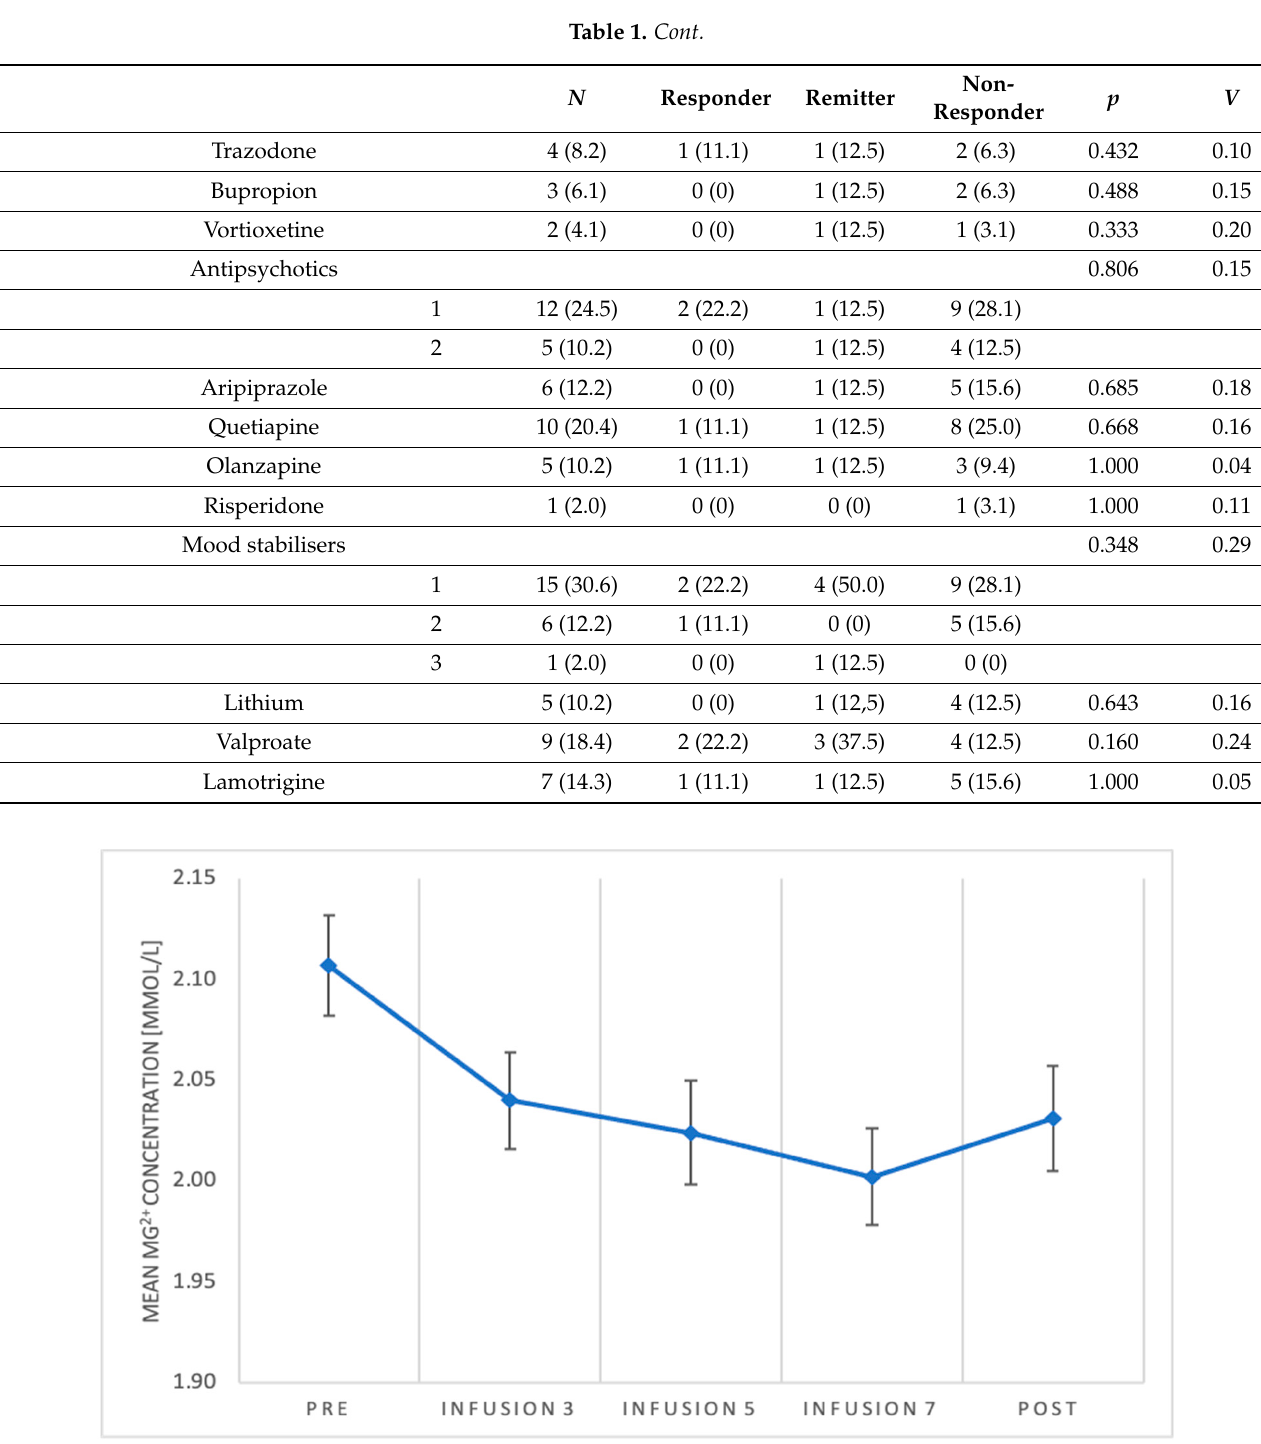
Figure 1. Mean Mg 2+ concentration and standard errors of the mean for the concentration of Mg 2+ in individual measurements.